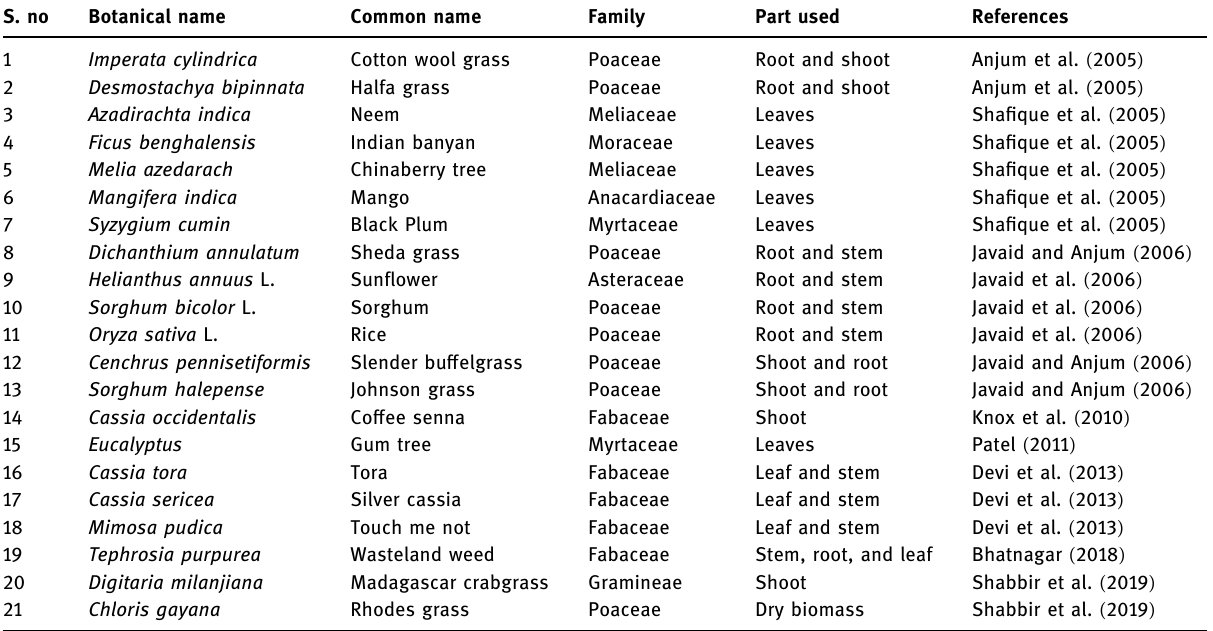
Table 2: List of allelopathic plants used for suppressing the growth and germination of the weed ( P. hysterophorus ) S.